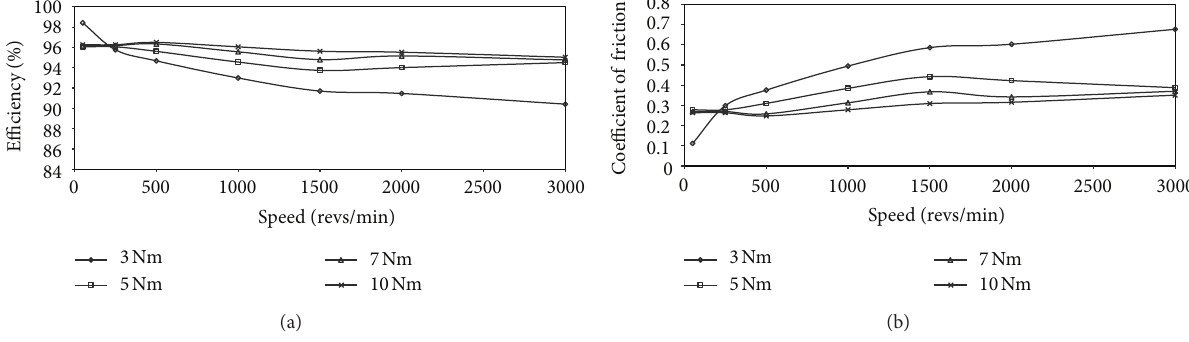
F 8: Showing (a) the efficiency and (b) the derived coefficients of friction for 30